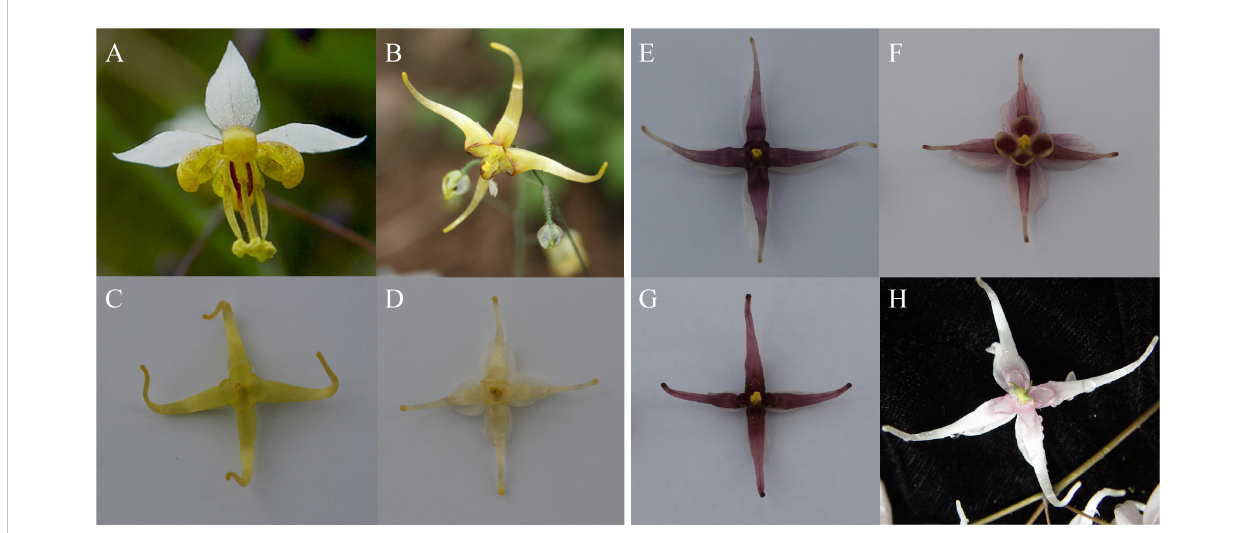
FIGURE 2 Floral phenotypes of accessions of different species within the genus Epimedium . (A – D) are non-pigmentation species (A-); (E – H) are classi fi ed as pigmentation species (A+). All photos were taken by W. S. (A) E. sagittatum , (B) E. lishihchenii , (C) E. franchetii , (D) E. wushanense , (E) E. zhushanense , (F) E. epstenii , (G) E. acuminatum , (H) E. leptorrhizum